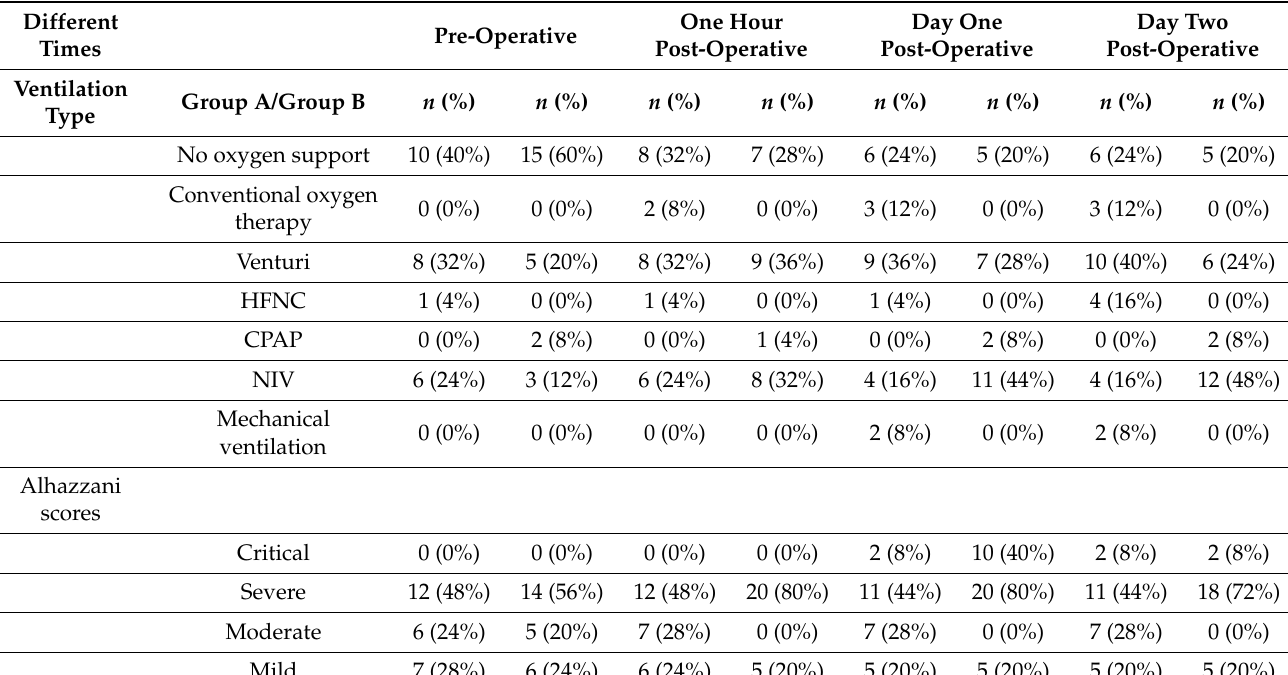
Table 3. Ventilation type and Alhazzani scores divided by Surgical Approach at different times for study group.